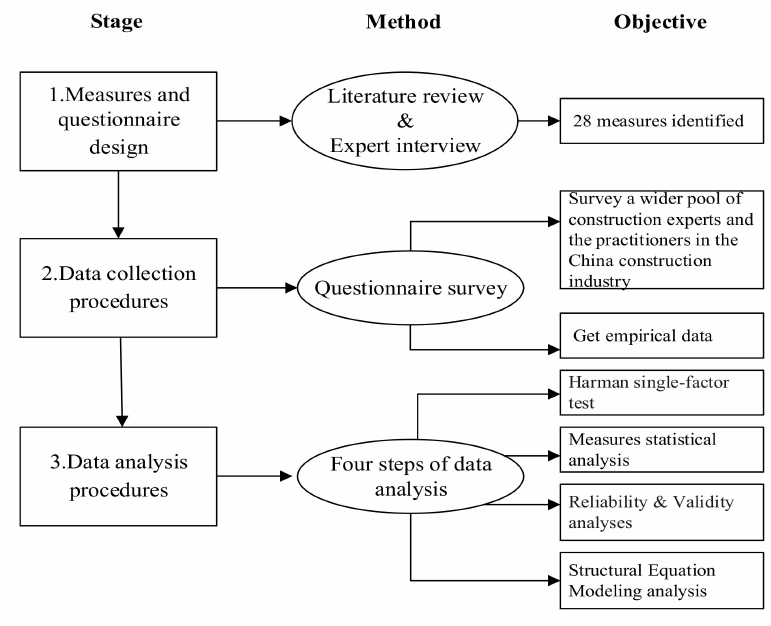
Figure 3. Three-stage research methodology.